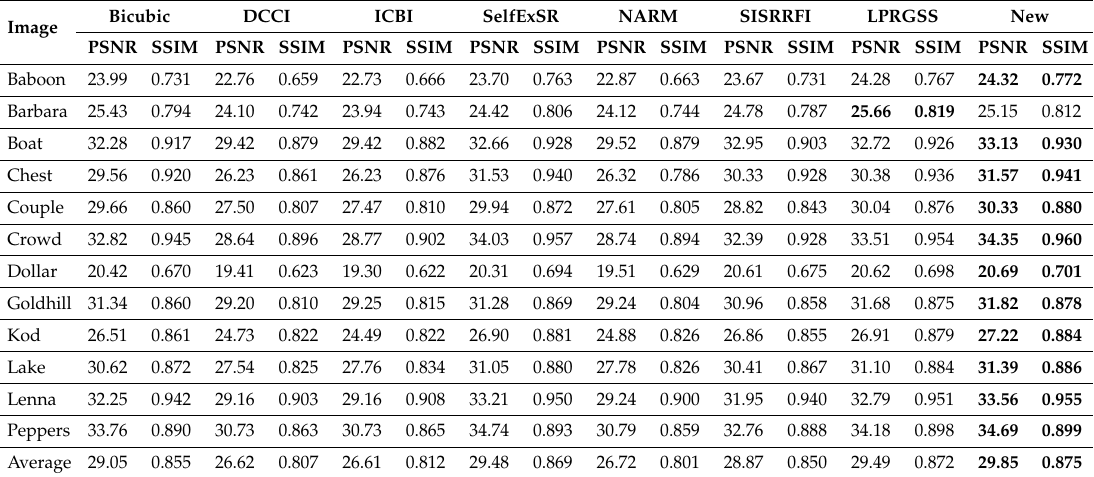
Table 1. Peak Signal-to-Noise Ratio (PSNR) and Structural Similarity (SSIM) values of 12 magnified images by 8